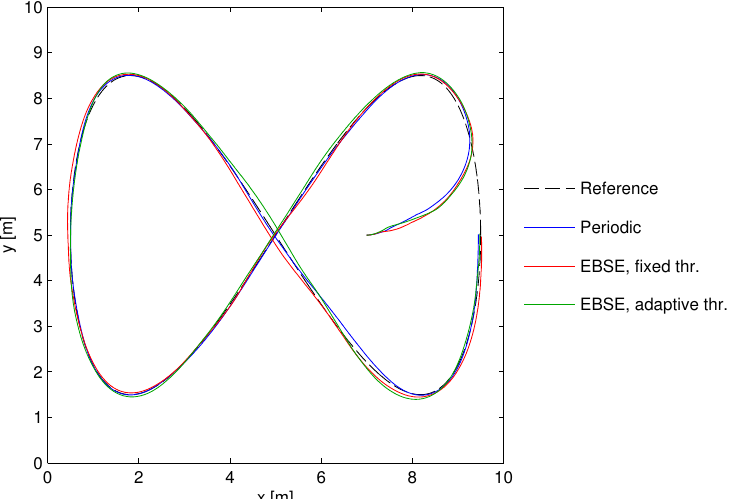
Figure 6. Comparison of the trajectory followed by the three sampling schemes, as well as the reference trajectory. The position of the camera sensors and their field-of-view (FOV) are also